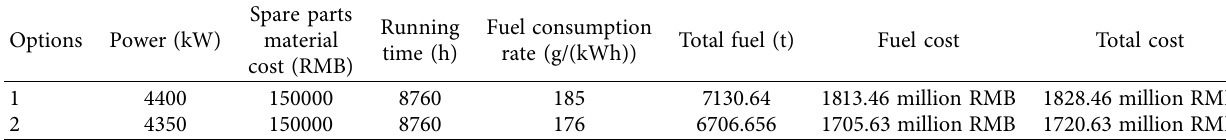
Table 5: Operating cost.